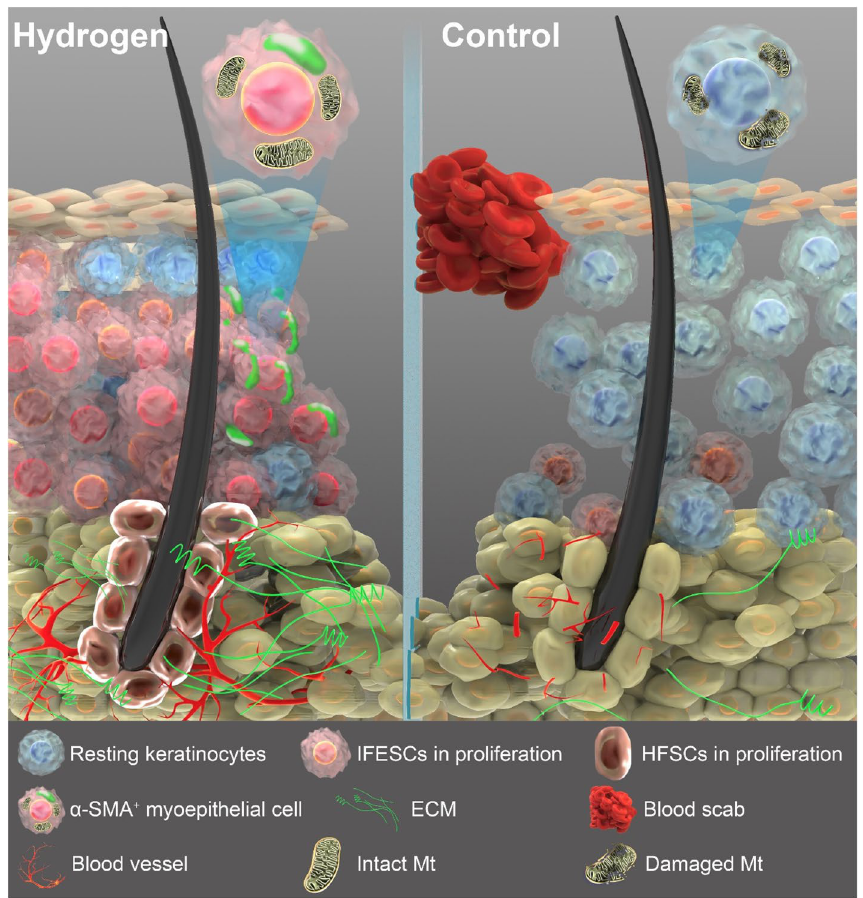
Fig. 7 Schematic representation of the skin under H 2 treatment and normal conditions during the early stage wound healing. In addition to anti-inflammation (especially for Th1- and Th17-related systemic inflammation), H 2 treatment brings multiple other benefits (shown in the figure) including faster epidermis thickening, earlier proliferation (red nuclei) of epidermal stem cells (basal cells and hair follicle cells), early differentiation of basal cells in the wound edge (differentiate towards α-SMA + cell type), earlier and better ECM deposit, faster blood vessel formation, mitochondrial damage repair, and moist healing process (less blood scab